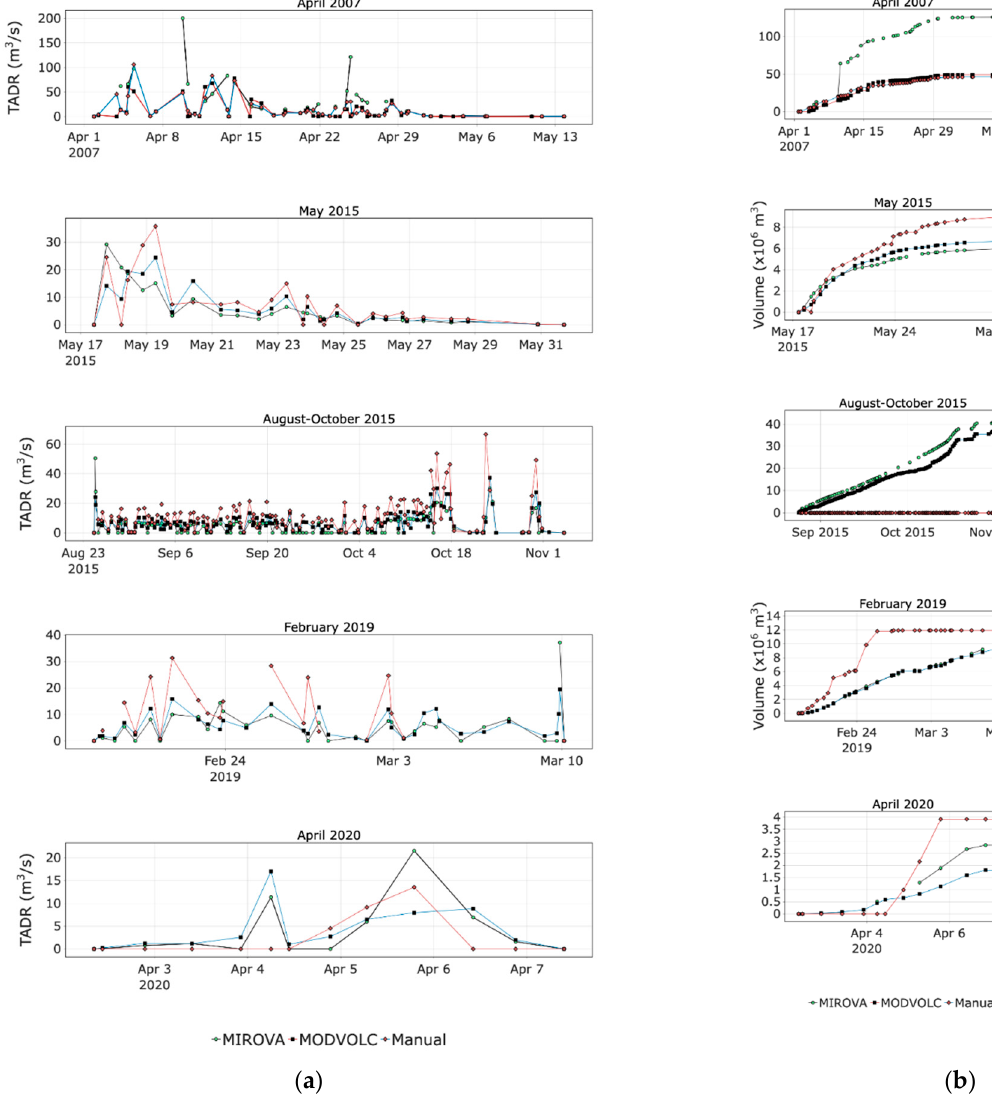
Figure 4. ( a ) The effusion rates and ( b ) the cumulative volumes of erupted lava for the following tions correspond to the MIROVA and MODVOLC automatic systems and the Manual method. Note that on the MIROVA dataset, the peak on 6 April 2007 that was manually corrected (200 m 3 s –1 ) was taken into account. By removing this corrected value, the lava volume estimation decreases to 52.1 ± 26.0 × 10 6 m 3 . The uncertainty is 30% except for the April 2007 eruption, where it rises to 50% due to saturation issues.